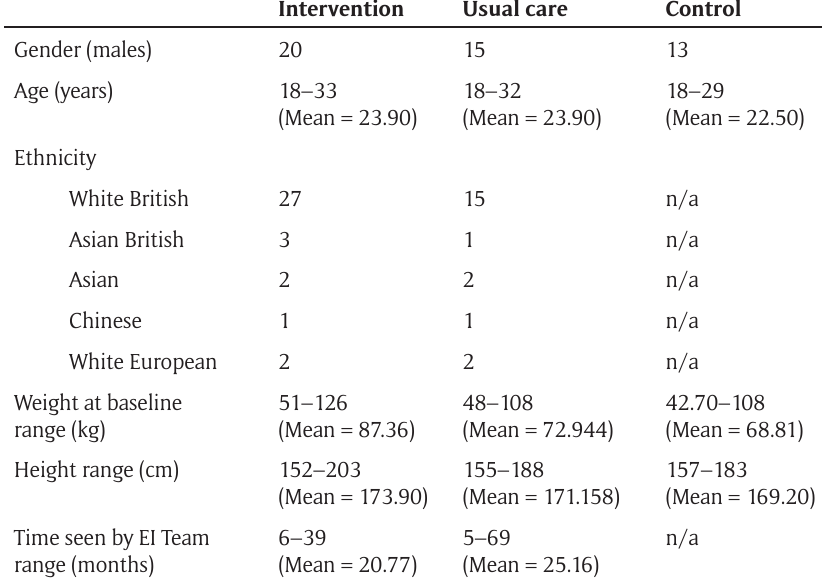
Table 2: Demographic characteristics of the three groups at T1. Intervention Usual care